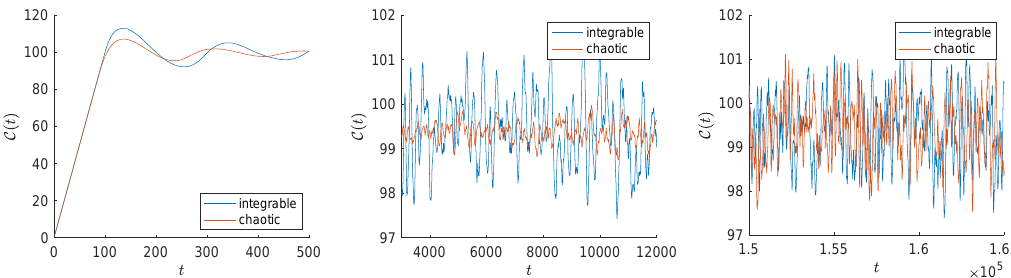
Figure 1: The bi-invariant complexity (2.17) for random energy spectra that mimic the energy level statistics expected from integrable and chaotic systems according to quantum chaos theory. The two curves are very similar, and the plateau properties are captured well by our estimates (2.23). The middle and right plots give an overview of the plateau at intermediate and late times, respectively. The numerically computed mean and variance of the two curves at late times are comparable and agree well with (2.23). A more subtle difference between the two curves is visible at intermediate times, where the chaotic curve momentarily displays a smaller vertical